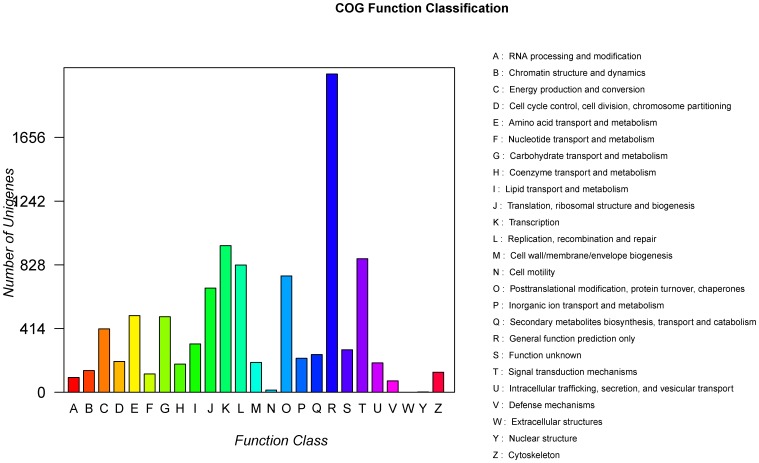
Histogram of the COG classification cluster of Chinese jujube sequences that were deposited in the NCBI database and de novo-assembled unigenes.A total of 950 assembled unigenes were annotated and fell into 24 clusters. The Abscissa is the content of the categories of COG, while the ordinate is the number of unigenes.